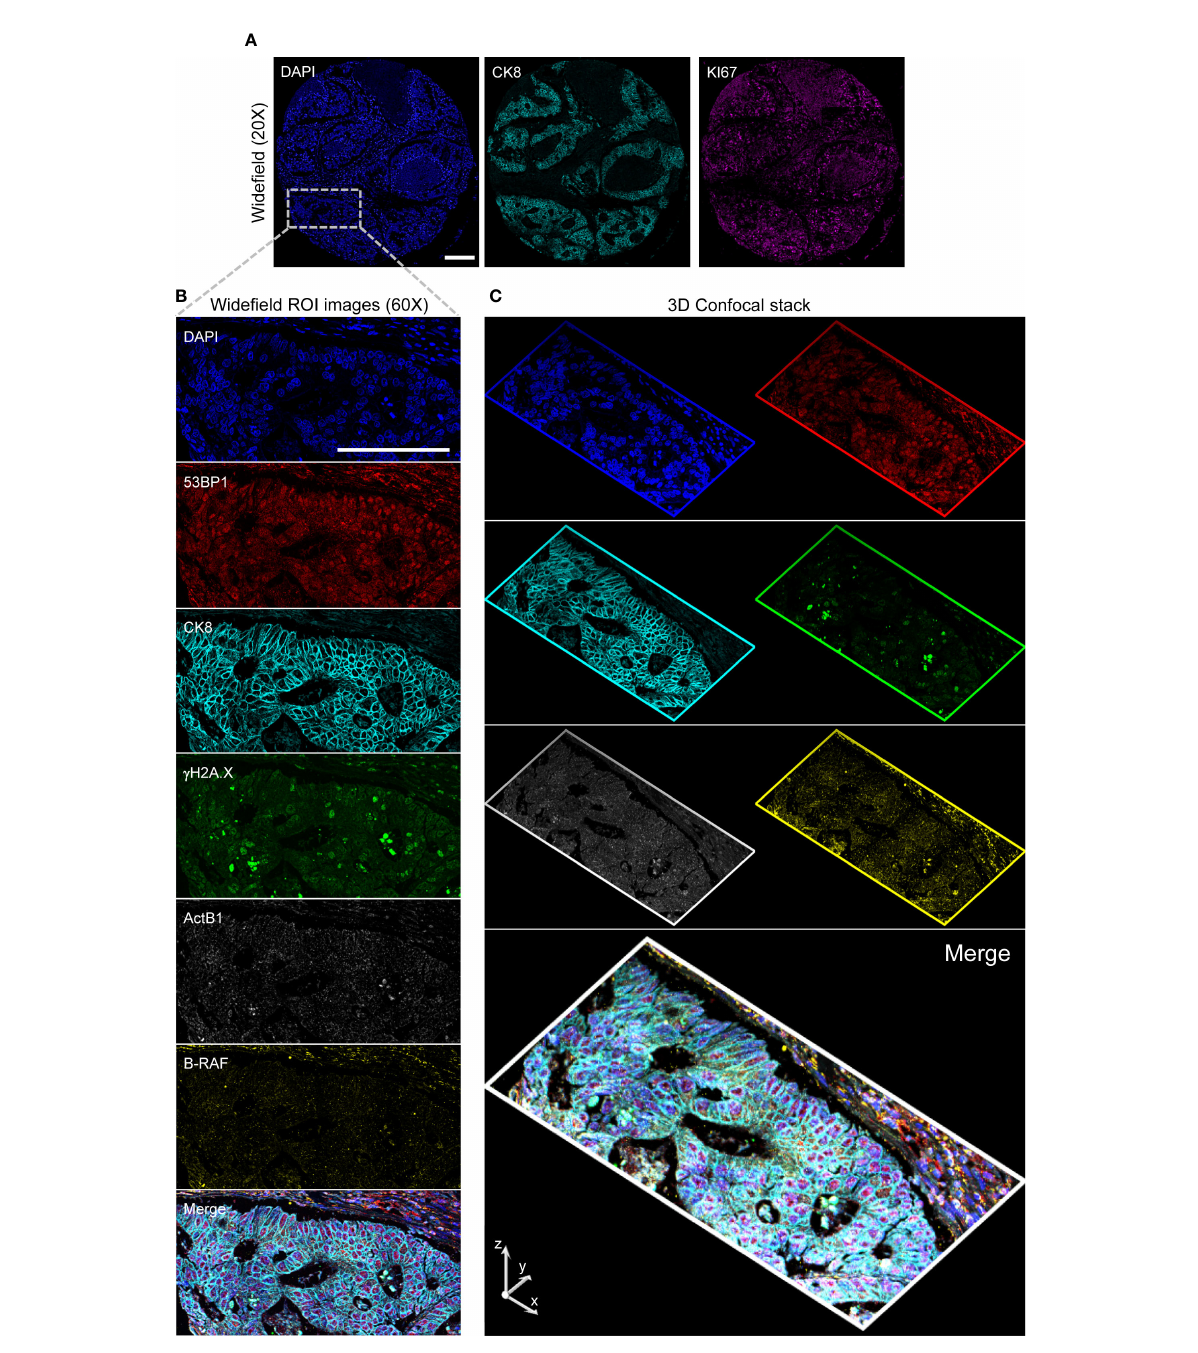
FIGURE 6 High-Resolution 3D Analysis of a targeted core. Panel (A) : Single cell resolved images (20x) of a selected core are collected and analyzed to target the CK8+ selected region (Inset. Blue: DAPI; Cyan: Ck8; Magenta: KI67) by conversion of the image- to microscope stage- coordinates. A 60x 1.4 NA Oil Immersion objective is then employed to acquire diffraction-limited wide fi eld (Panel B ) images and confocal stacks (Panel (C) stack max projections along the indicated axis) on the restained slide in two consecutive rounds. Images are then spatially registered to create the fi nal result: Blue: DAPI; Red: 53BP1; Cyan: Ck8 (restained after stripping); Green: g H2A.X; Grays: ActB1 RNA FISH; Yellow: B-RAF RNA FISH. Scale Bar: 200 m